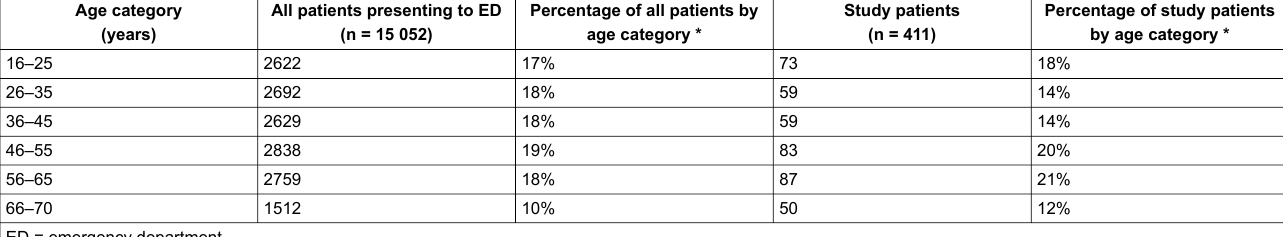
Study patients Percentage of study patients (n = 411) by age category